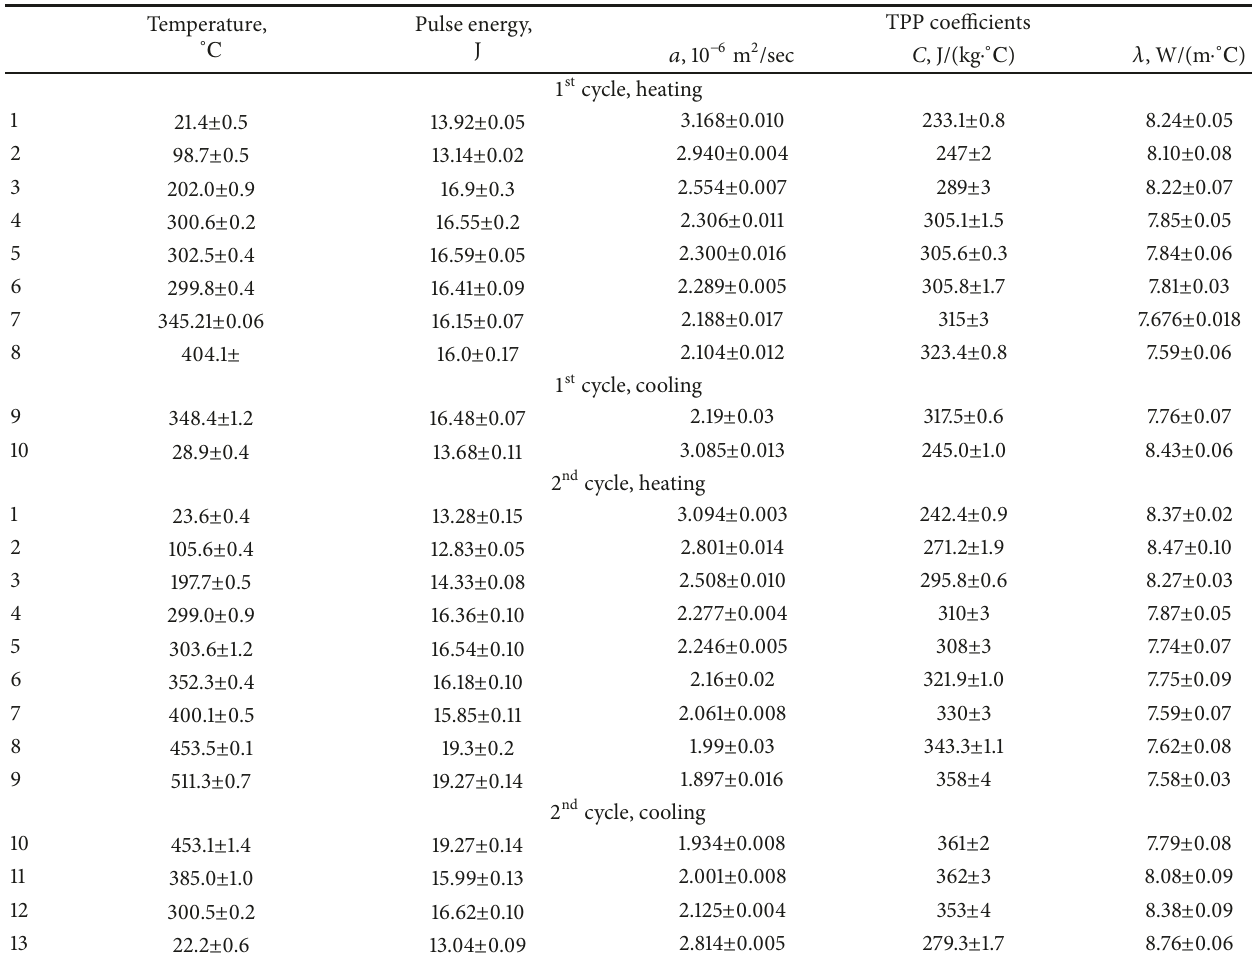
Table 3: The results of temperature measuring of TPP